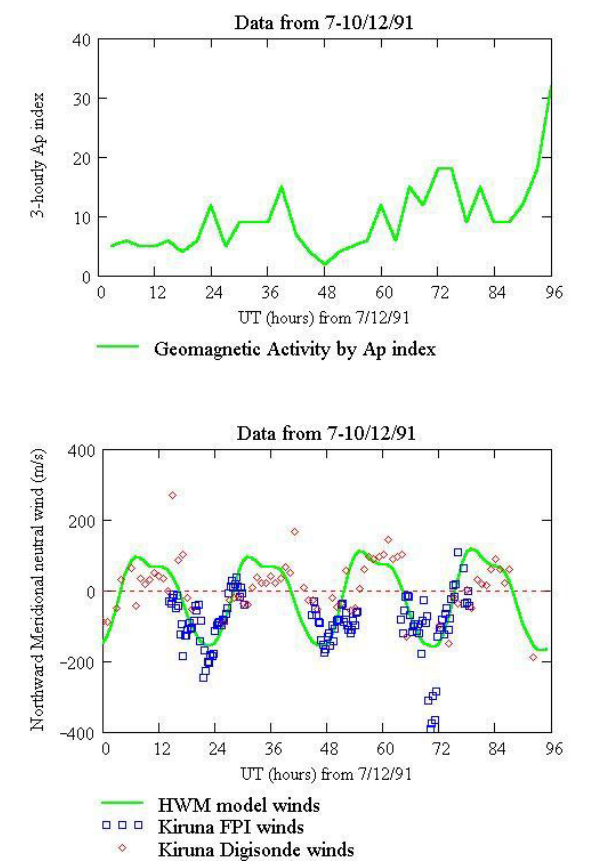
Fig. 6. HWM93 model winds are compared with directly measured winds from the Kiruna FPI and those derived winds from the Kiruna Digisonde over the period 07–10 December 1991. The top plot shows the time series of the A p index for these days.